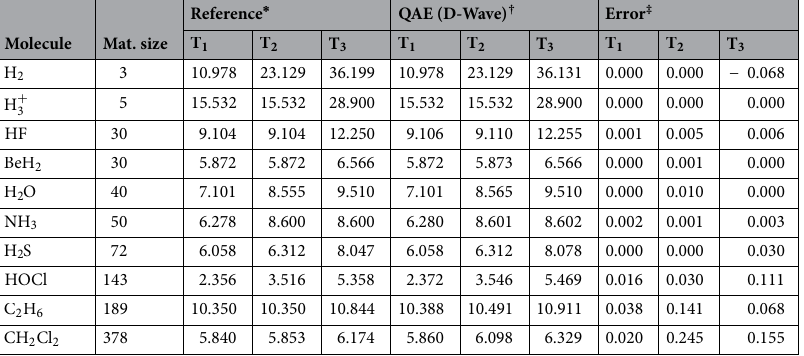
Table 2. Triplet TDDFT excitation energies (eV). ∗ Reference calculation on CPU using unmodified PySCF. † PySCF was modified to use the QAE and D-Wave 2000Q. ‡ Difference between the two types of calculation.